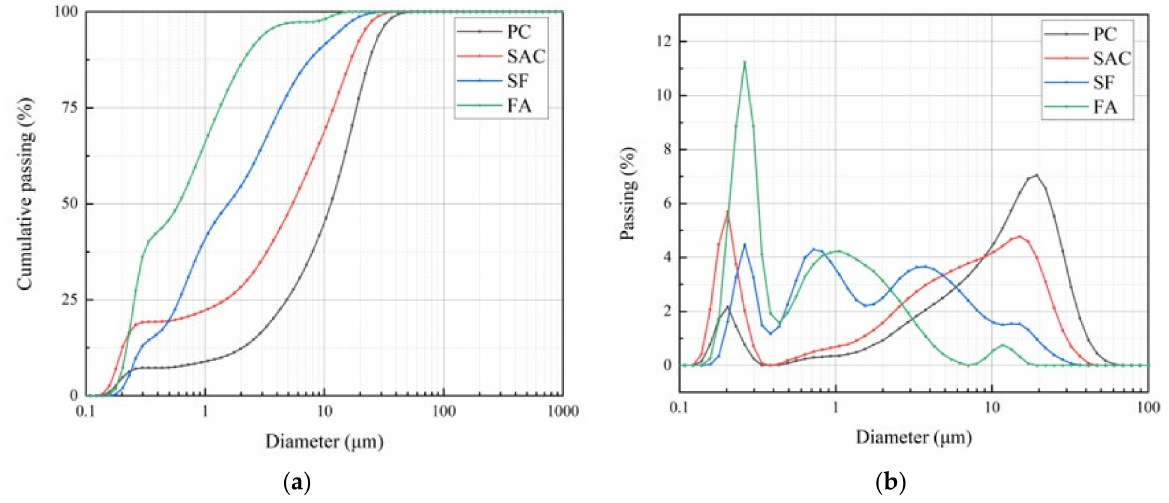
Figure 1. Particle size distribution of cementitious material: ( a ) Size distribution, ( b ) Frequency distribution. PC has a density of 3.112 g/cm 3 and specific surface area of 1186 m 2 /kg. SAC has a density of 2.9 g/cm 3 and specific surface area of 2717.33 m 2 /kg. SP has a solid content of 35%, water-reduction rate as high as 35%. F has a length of 13 mm, di- ameter of 0.22 mm, without fracture. QS has a particle size of 0.125~0.850 mm, using 0.425~0.850 mm:0.180~0.425 mm:0.125~0.180 mm =